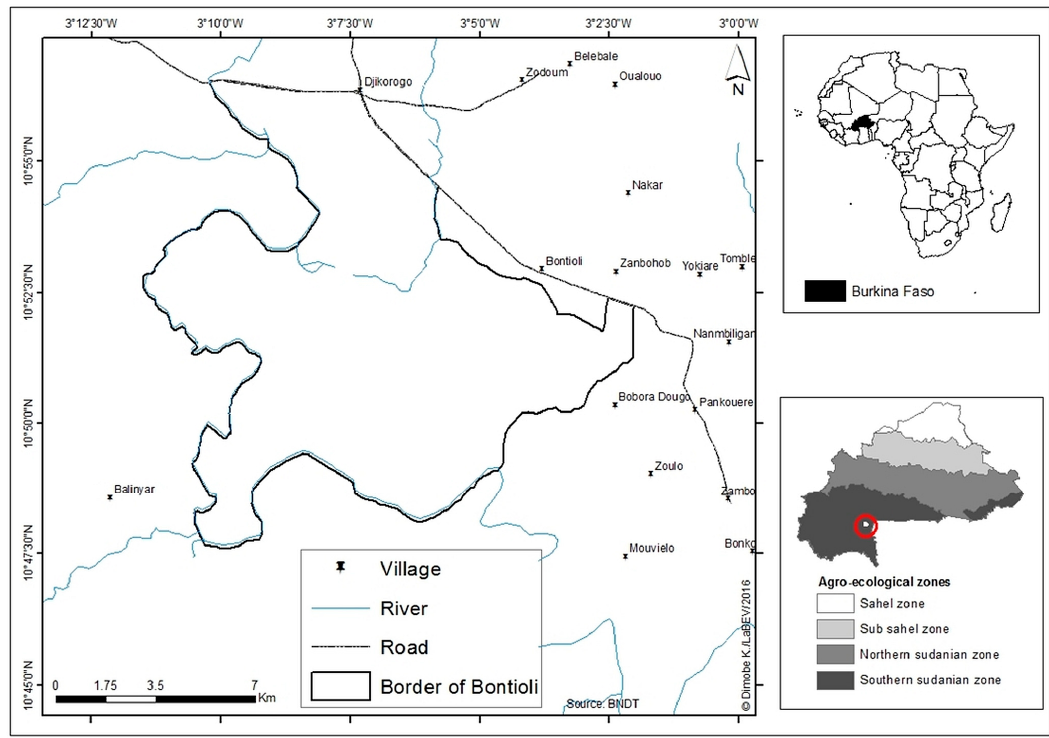
Figure 2. Bontioli Nature Reserve, Burkina Faso.